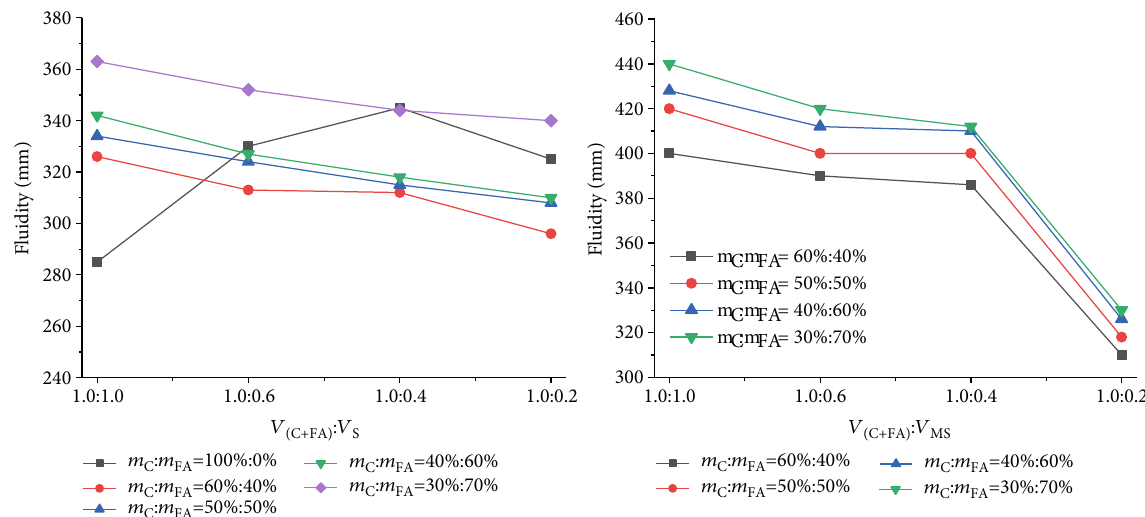
Figure 4: Curve of fl uidity. Note: m C-FA slurry to the pure S solution, and V ð